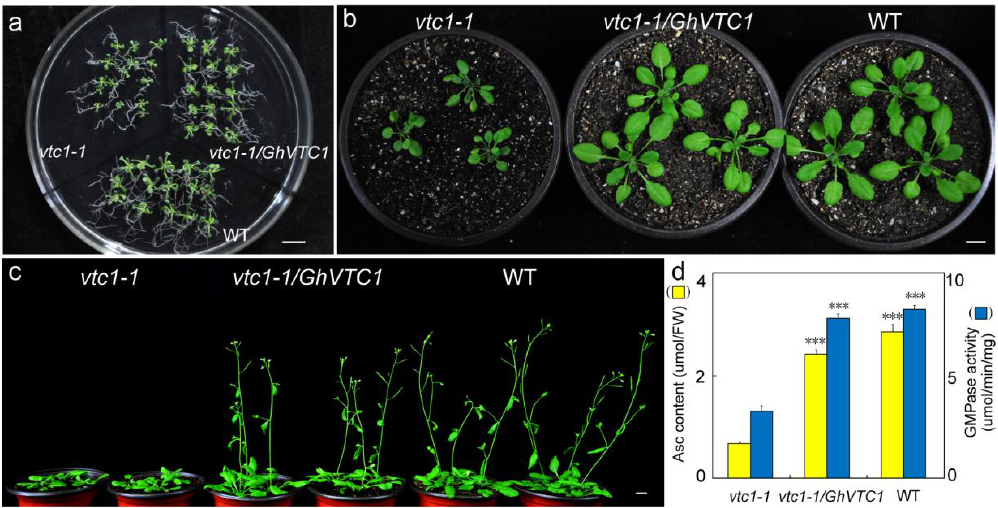
Figure 4. Functional complementary analysis of GhVTC1 in the loss-of-function Arabidopsis vtc1-1 mutants. The phenotypes of Arabidopsis plants including vtc1-1 mutants, WT, and transgenic vtc1-1/GhVTC1 by the ectopic expression of GhVTC1 in vtc1-1 mutants were observed. The 2-week-old seedlings ( a ), 4-week-old seedlings ( b ), and 6-week-old plants ( c ) were photographed for phenotype analysis. Bars = 1 centimeter (CM). ( d ) The Asc content and GMPase activity were measured in vtc 1-1 , vtc1-1/GhVTC1 , and WT Arabidopsis materials. ***, p < 0.001 compared to vtc1-1 . Error bars display the standard error from three independent experiments.